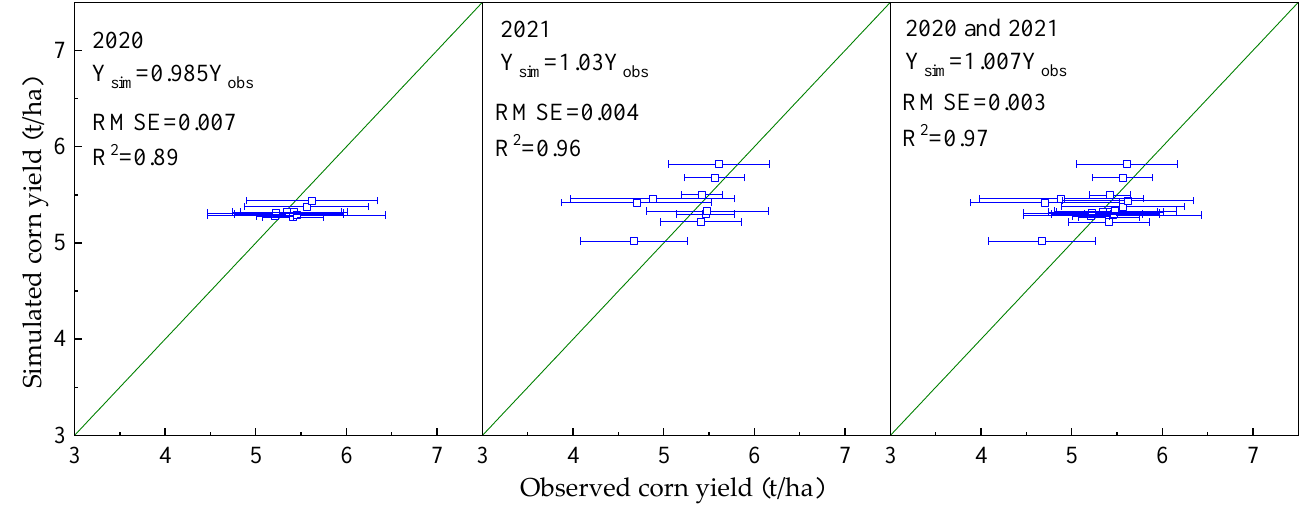
Figure 5. Observed and simulated maize yields for 2020 and 2021 seasons. The error bars represent standard deviations.